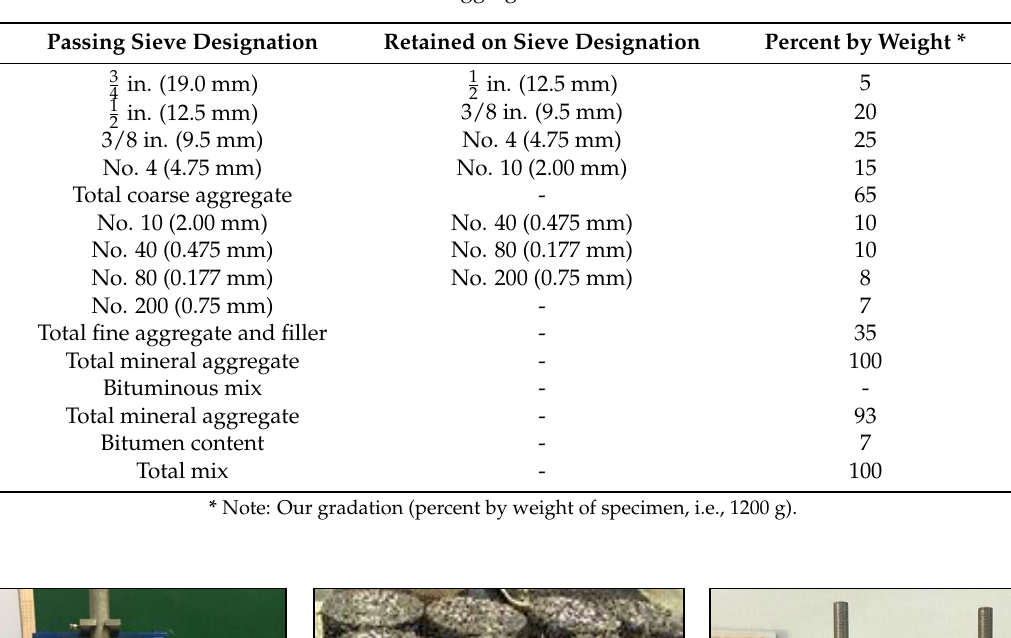
Table 3. Gradation of aggregates for bituminous mixes.